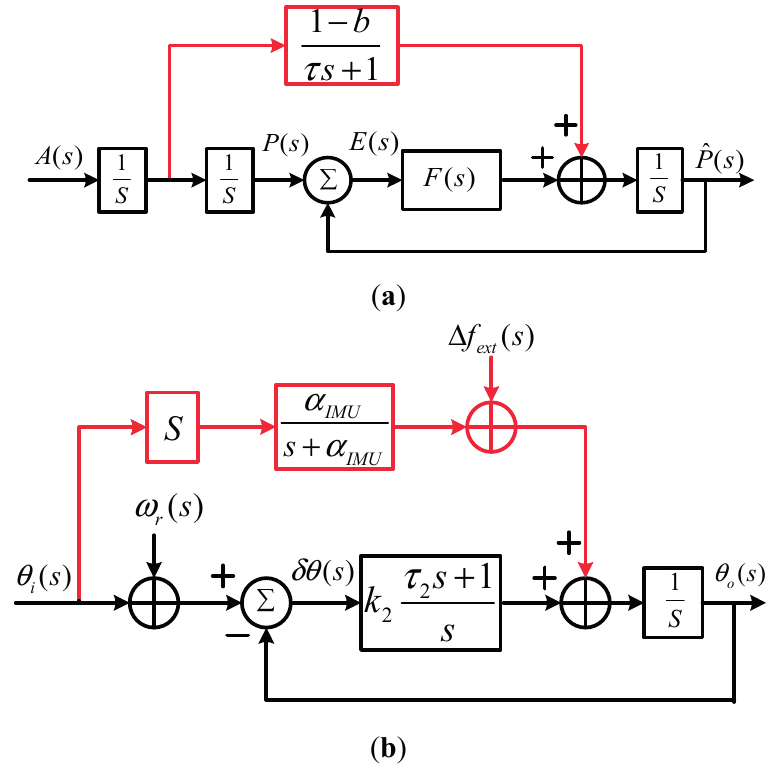
Figure 2. INS-aided GNSS receiver tracking loop model in previous work [9,10]. ( a ) Proposed by He et al. ; ( b ) proposed by